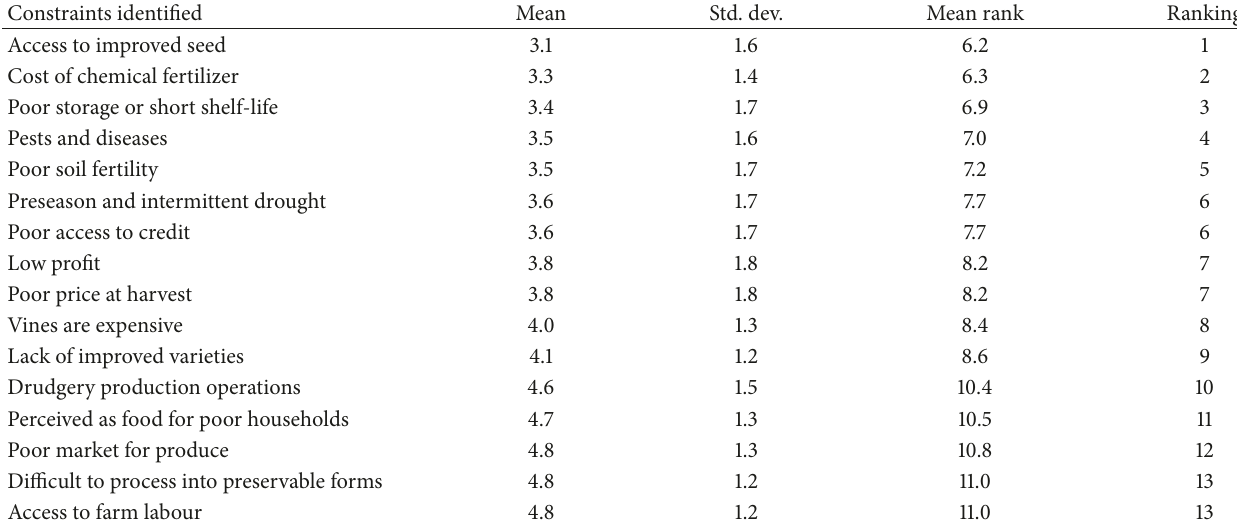
Table 7: Farmers perception and ranking of critical production